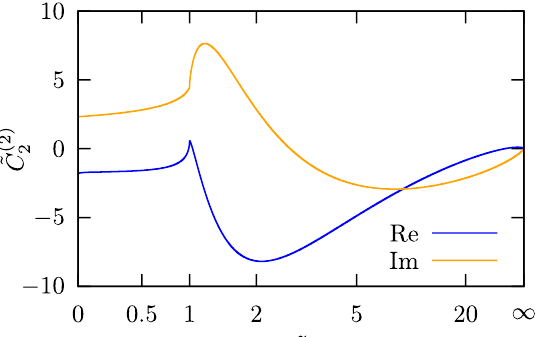
˜ to the ggH C (2) 2 H